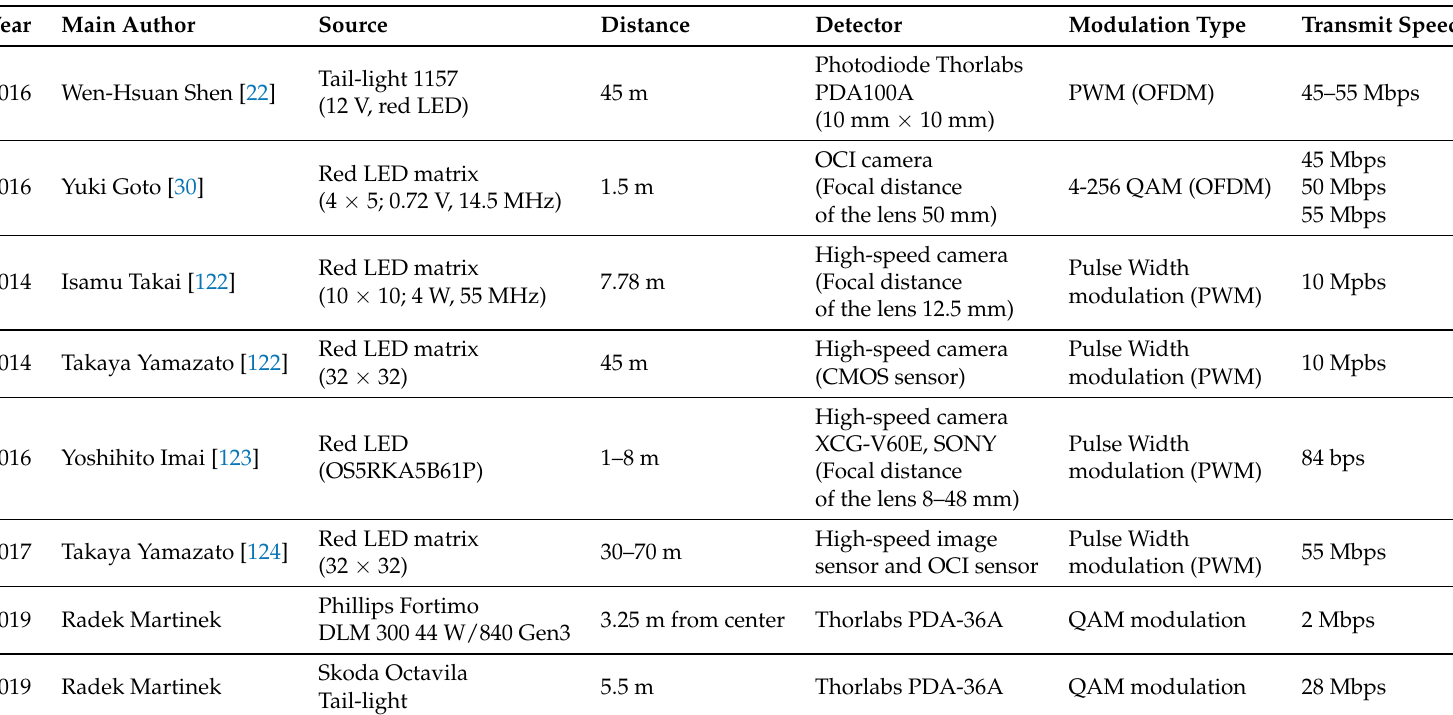
Table 5. Comparison of different VLC